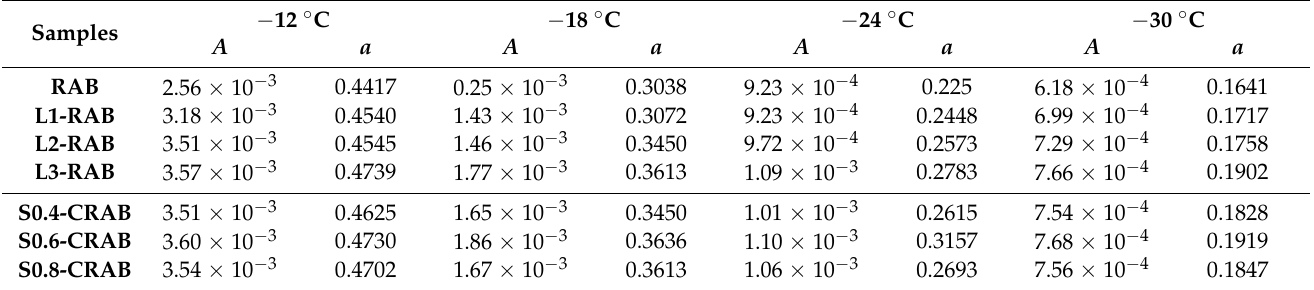
Table 4. Simple fractional viscoelastic model parameter for all asphalt binders.